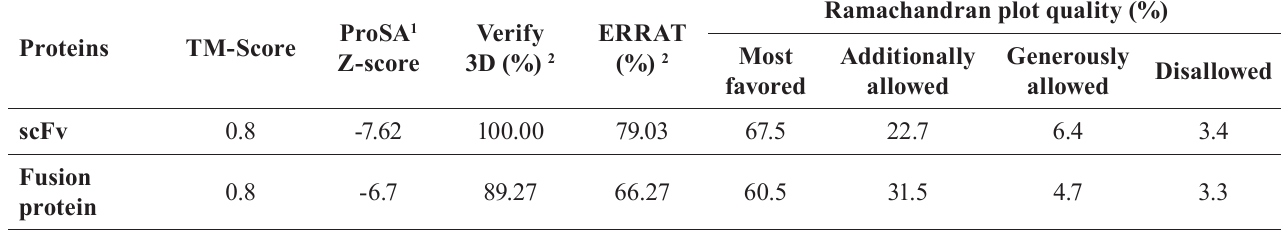
TABLE II - Structural validation of predicted models